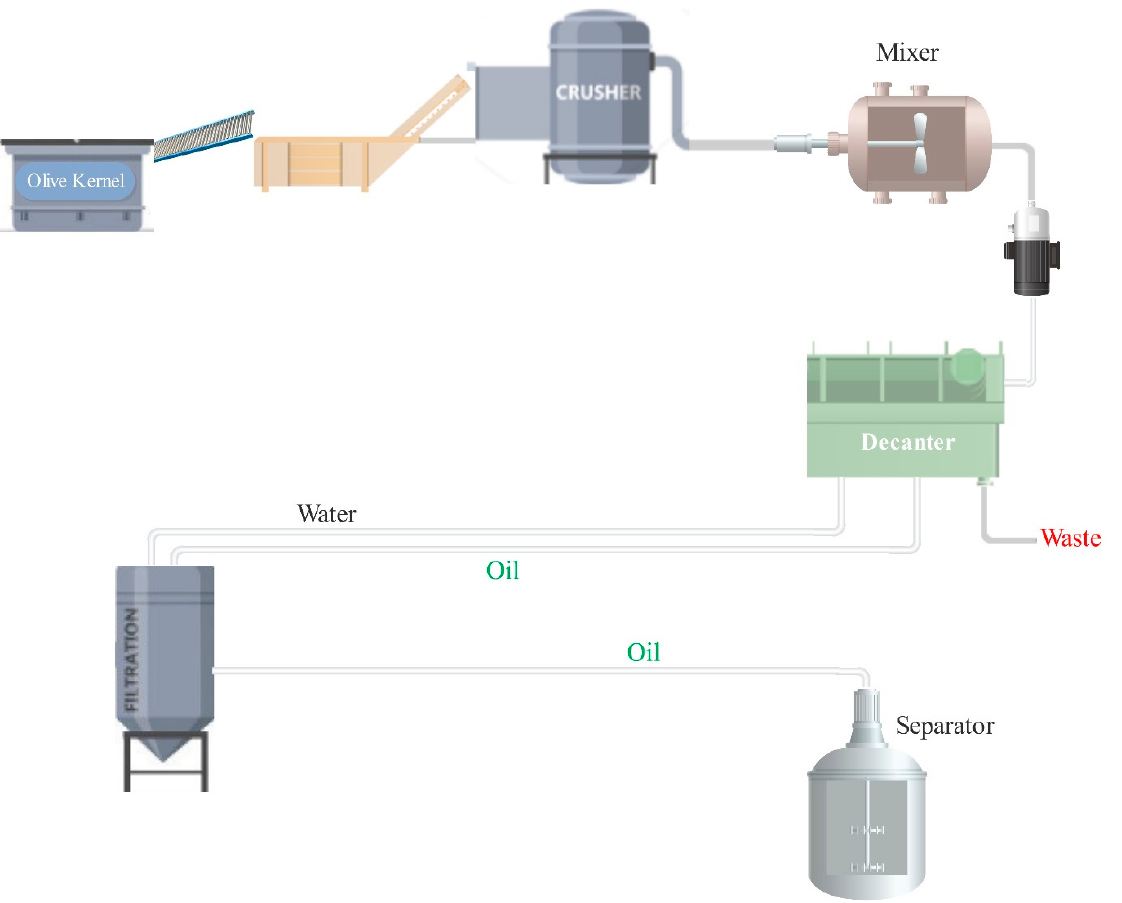
Figure 2. ( a ) different parts of an olive fruit [40,41], ( b ) the parts of the olive which were used to produce oil in the case study. Note: In this study, the term “kernel” refers to “kernel, pit, and pulp stuck to kernel”.